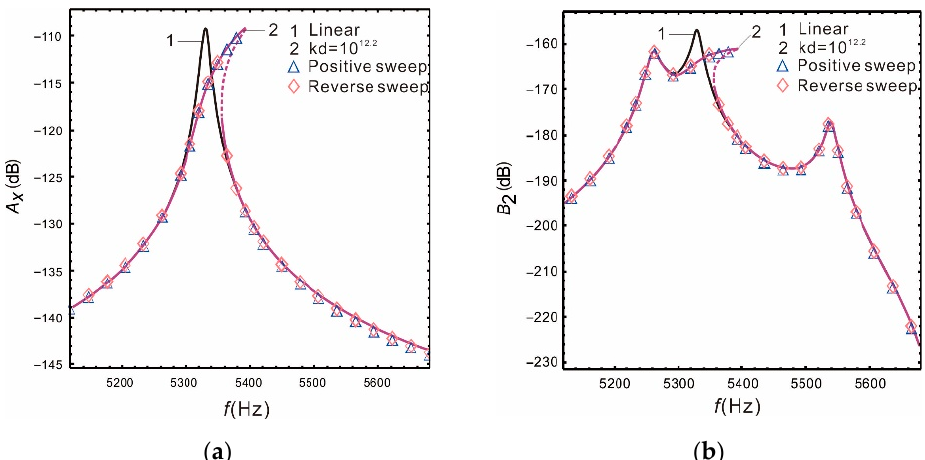
Figure 5. Comparison of Runge—Kutta methods and multiple time scales method: ( a ) drive mode; ( b ) sense mode.